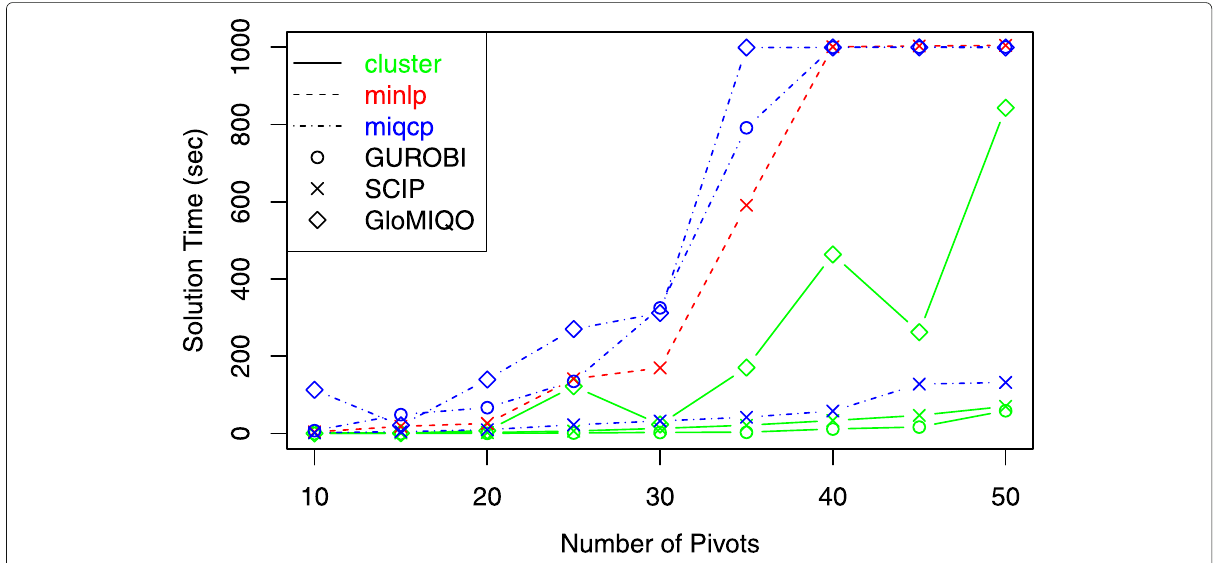
Fig. 4 Scalability comparison of different formulations and solvers for the EPC problem MIQCP formulation of the EPC model are most scalable and should be used in the iterative framework for com- puting the lower bound. We will use SCIP to solve the Cluster model and use GUROBI to solve the EPC model in subsequent